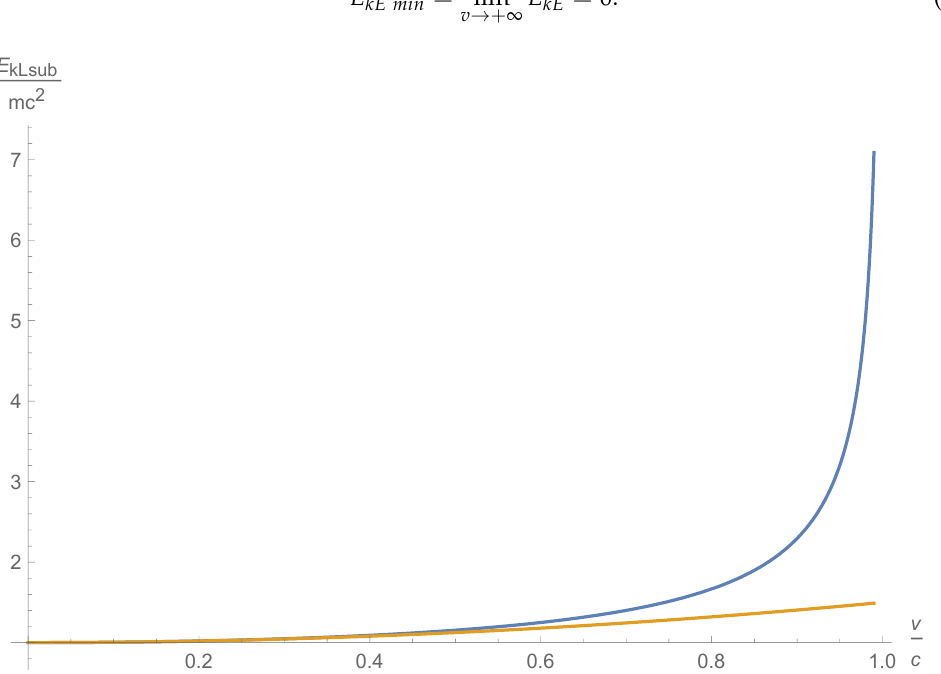
Figure 6. Kinetic energy for Lorentzian subluminal particles, the correct expression is com- pared with the classical one. The blue line is the correct expression while the orange line is the classical